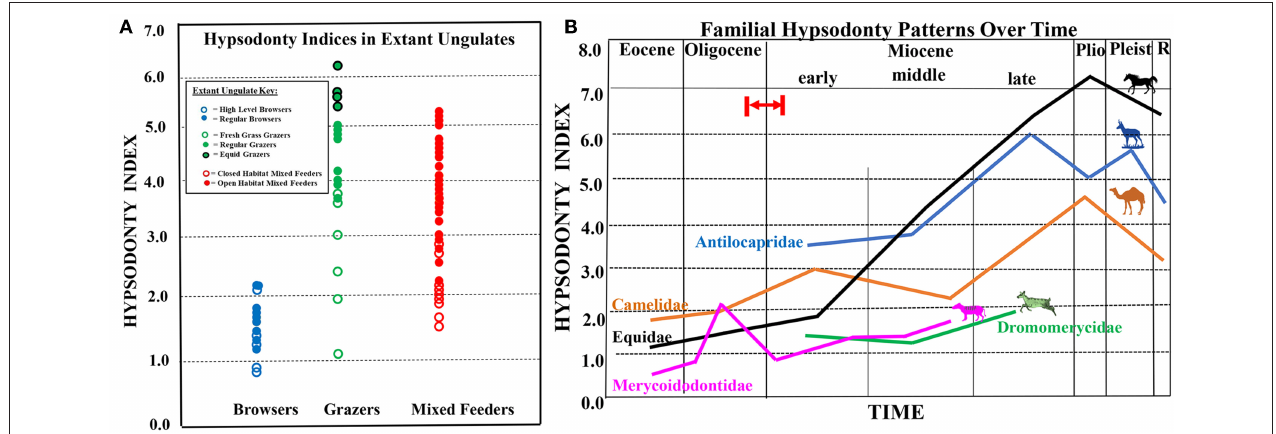
FIGURE 1 | (A) Extant ungulate m3 hypsodonty indices (data from Janis, 1988; modified from Semprebon and Rivals, 2010). Extant ungulates are represented by circles (closed circles = regular browsers, grazers, and mixed feeders; closed circles with black outlines represent equid grazers; open circles = high-level browsers, fresh grass grazers, and closed habitat mixed feeders). (B) Composite figure showing hypsodonty trends through time for equids (black line), antilocaprids (blue line), camelids (orange line), dromomerycids (green line), and oreodonts (pink line). Red arrow and red lines indicate probable timing of first availability of grass in the North American Great Plains Region by ∼ 22 million years ago (earliest Miocene), but possibly by even about 26 million years ago (latest Oligocene) based on phytolith data from (Strömberg, 2011). Please note that hypsodont equids will likely always have higher hypsodonty indices than ruminants on a similar diet, due to differences in digestive physiology and ingestive